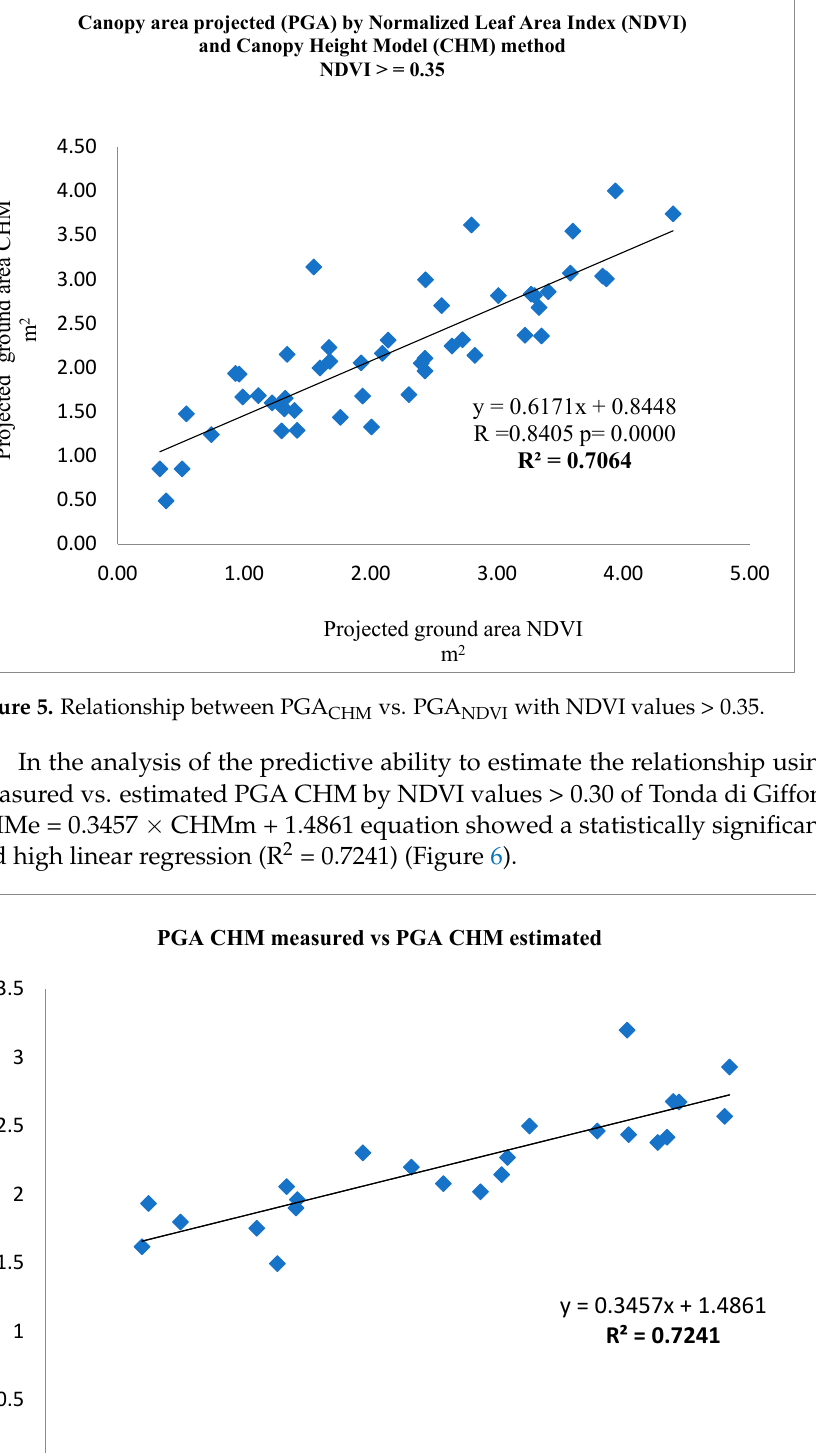
Figure 4. Relationship between PGA CHM vs. PGA NDVI with NDVI values > 0.30.